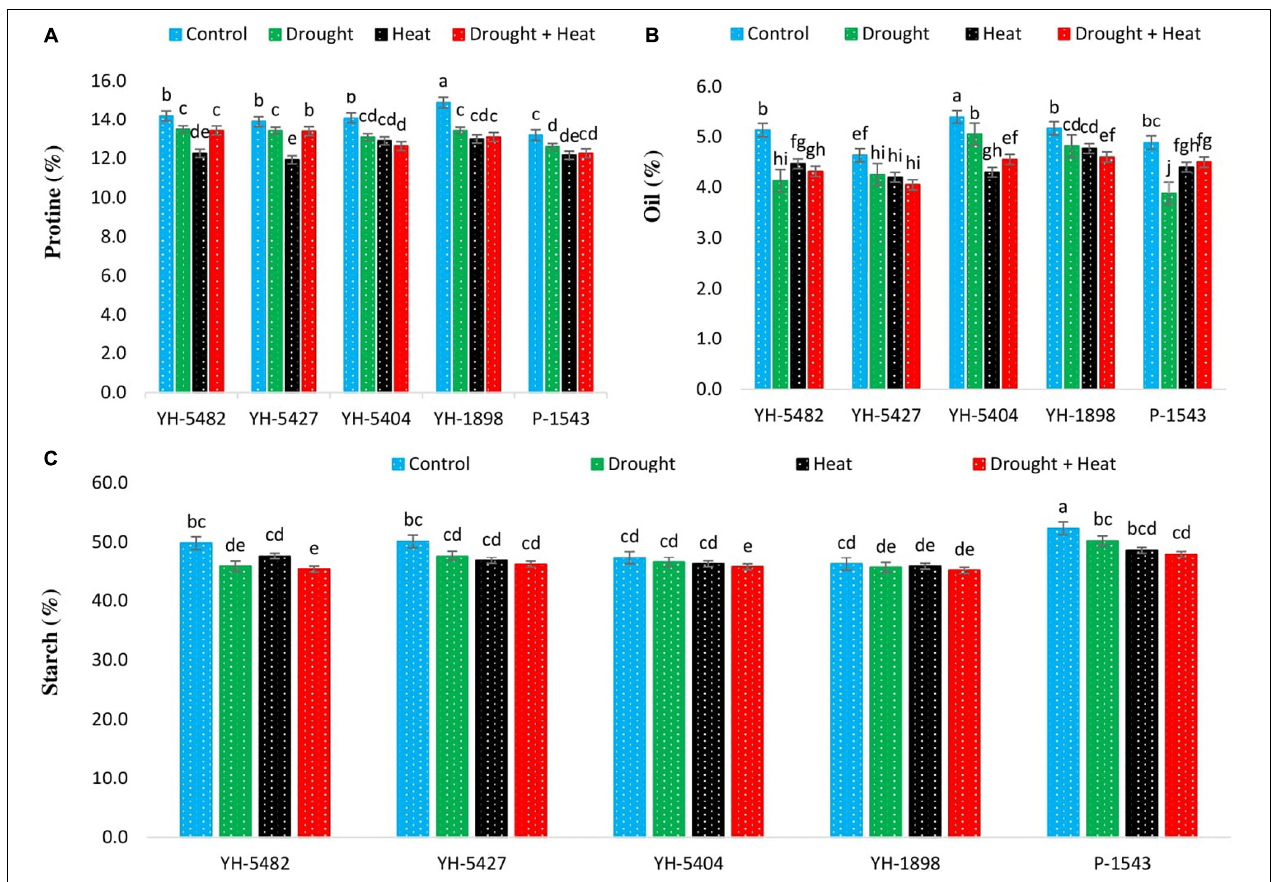
FIGURE 7 | Effect of heat, drought, and heat +drought stress on (A) Protein contents % (B) Oil contents % and (C) Starch contents % in five maize hybrids. Capped bars above means represent the ± SE of three replicates.